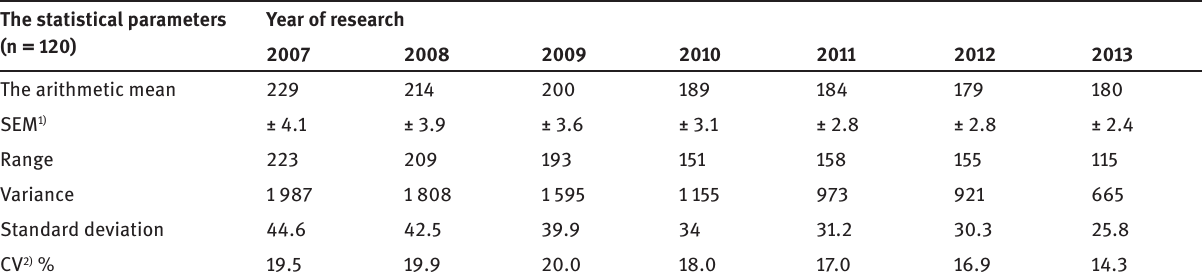
Table 6: The impact of variable fertilization on changes in the content of the available form of potassium (mg kg -1 soil) in the light soil – Przeworno.